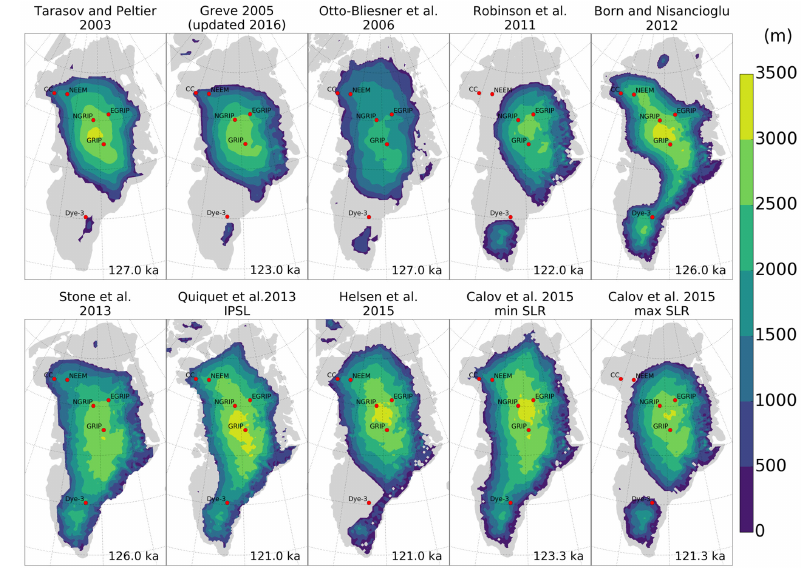
Figure 2. Overview of previously modeled minimum ice extent and topography of the Eemian GrIS. The number in the lower right corner of each panel refers to the timing of the minimum ice extent in the respective simulation. Deep ice core locations are indicated with red circles.